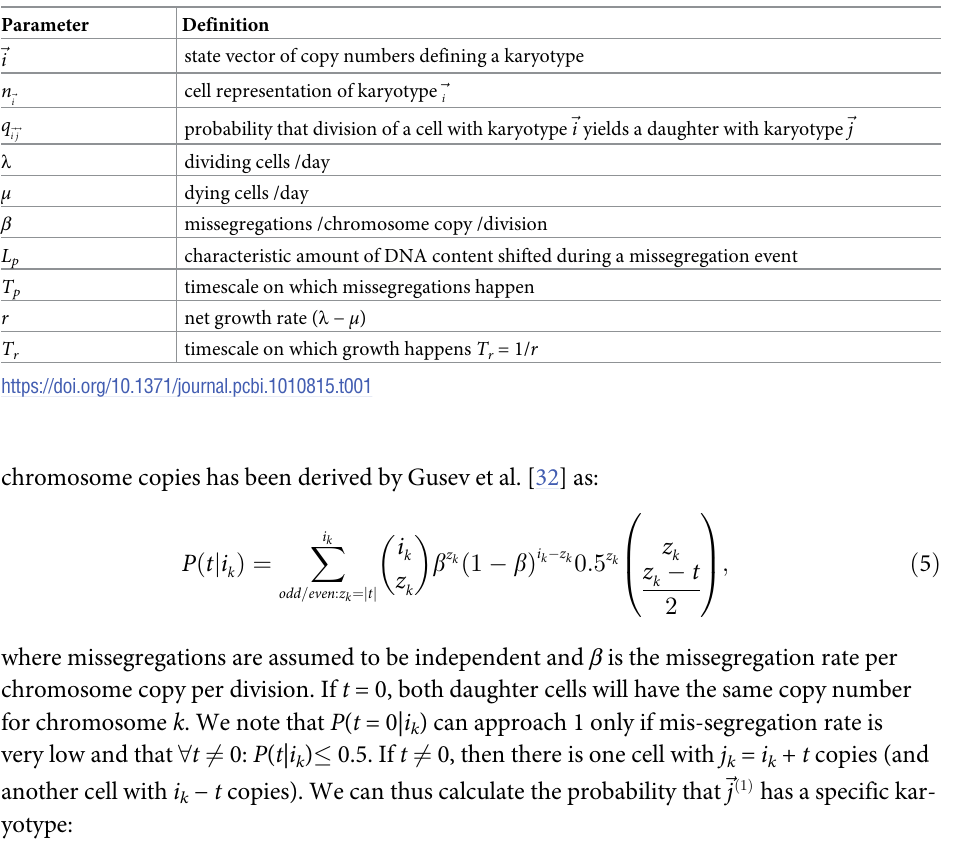
Table 1. Common model parameters used throughout the